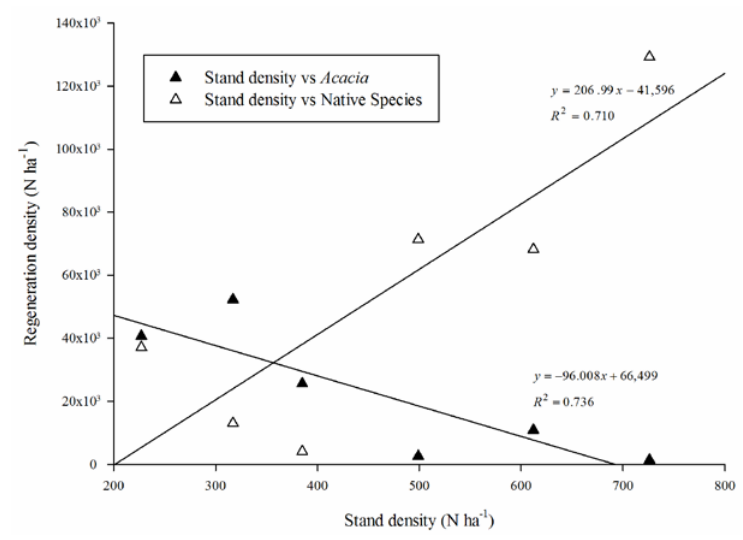
Figure 2. Linear regression analysis between the pine stand density and the native woody species and Acacia saligna regeneration.